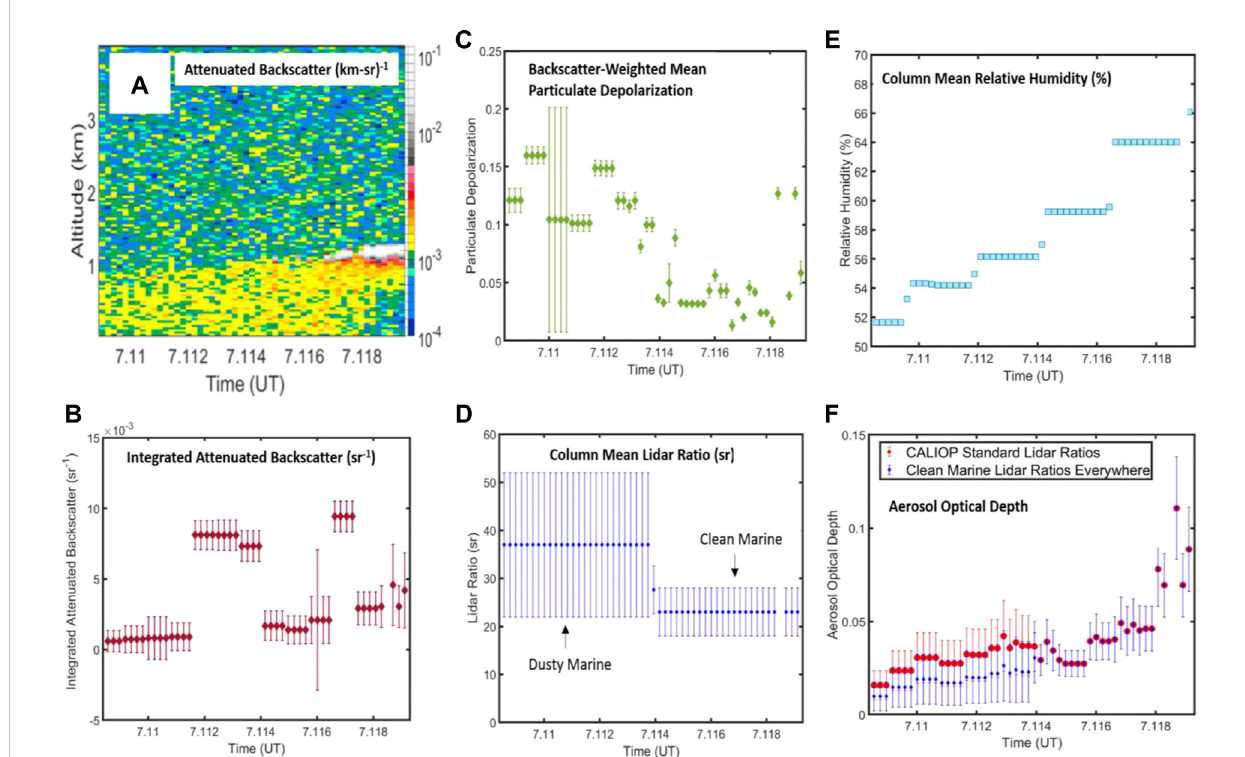
FIGURE 13 CALIOP (A) level 1 pro fi les of attenuated backscatter at 532 nm, (B) level 2 pro fi les of integrated attenuated backscatter at 532 nm, (C) backscatter- weighted meanintegratedparticulatedepolarizationratioat532 nm, (D) column meanlidar ratioat532 nm, (E) columnmean RHfromMERRA-2model, and (F) tropospheric aerosol optical depth at 532 nm derived from the CALIOP data using the standard lidar ratios (red) and lidar ratios corresponding to clean marine aerosol (blue). All panels correspond to the period 07:06 – 07:14 UT on 9 March 2020 when CALIOP acquired data in the region of the aircraft fl ights shown in Figure